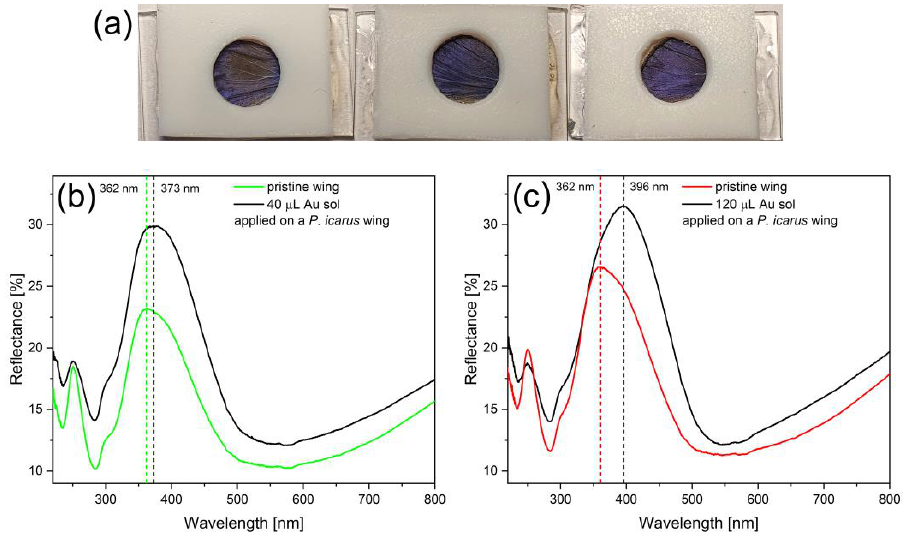
Figure 3. Reflectance measured on the wings of a male Polyommatus icarus butterfly before and after the drop-drying of sodium citrate-based Au NP sol. ( a ) Measurement in normal incidence: red and green curves show the pristine status, and the black and blue curves were taken after the complete drying; ( b ) measurement with an integrating sphere: red and green curves show the pristine status, and the black and blue curves were taken after the complete drying.